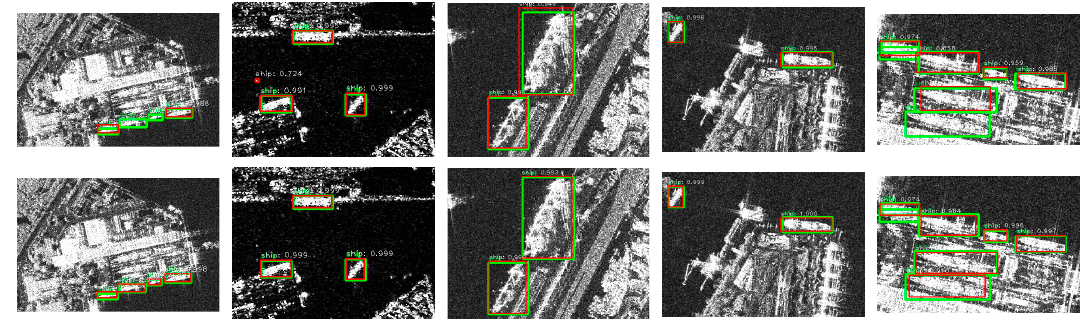
Figure 10. Comparison results of FPN and HRFPN in the inshore and offshore scenes. Row 1 is the result of FPN; Row 2 is the result of HRFPN. Red boxes denote predicted results; green boxes denote the ground-truth.